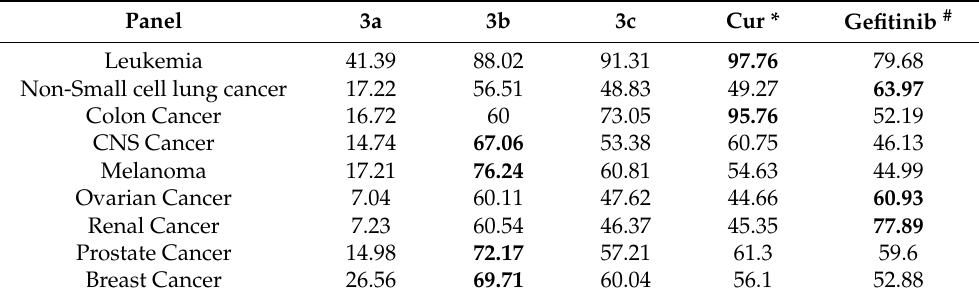
Figure 5. ( a ). The % GIs of curcumin analogs ( 3a – c ) and curcumin (Cur) on leukemia, non-small cell lung, colon, and CNS cancer panels. ( b ). The % GIs of curcumin analogs ( 3a – c ) and curcumin (Cur) on melanoma, ovarian, renal, prostate, and breast cancer panels. Table 3. Mean % GI of compounds 3a – c , curcumin and gefitinib at 10 µ